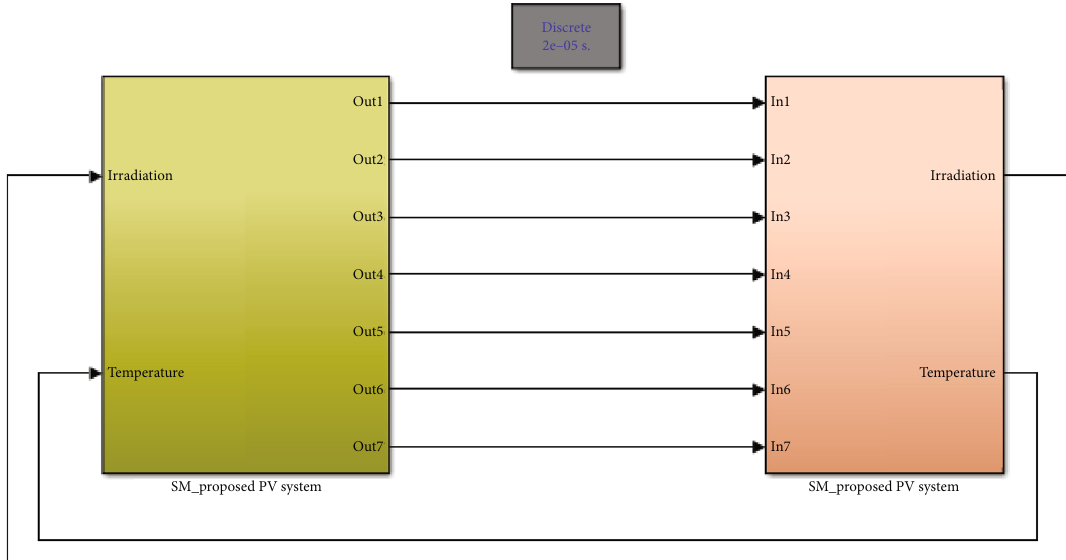
Figure 22: Simulink schematic modeling-based RT-LAB simulator of the complete PV system.